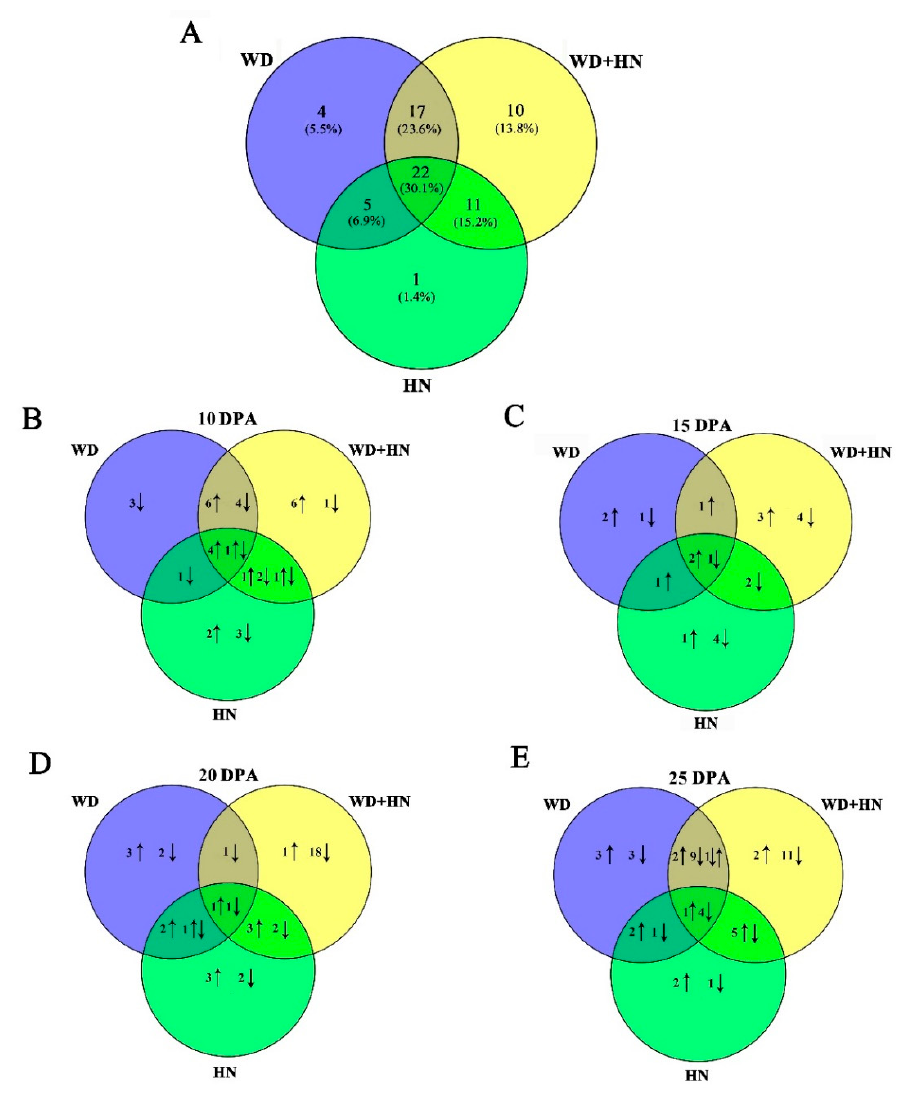
Figure 3. Venn diagrams of 72 di ff erentially accumulated protein (DAP) spots from flag leaves during grain development under water-deficit, high-nitrogen (N) fertilization, and combined treatments. ( A ) Total DAP spots from wheat flag leaves under di ff erent treatments. DAP spots at ( B ) 10, ( C ) 15, ( D ) 20, and ( E ) 25 days.